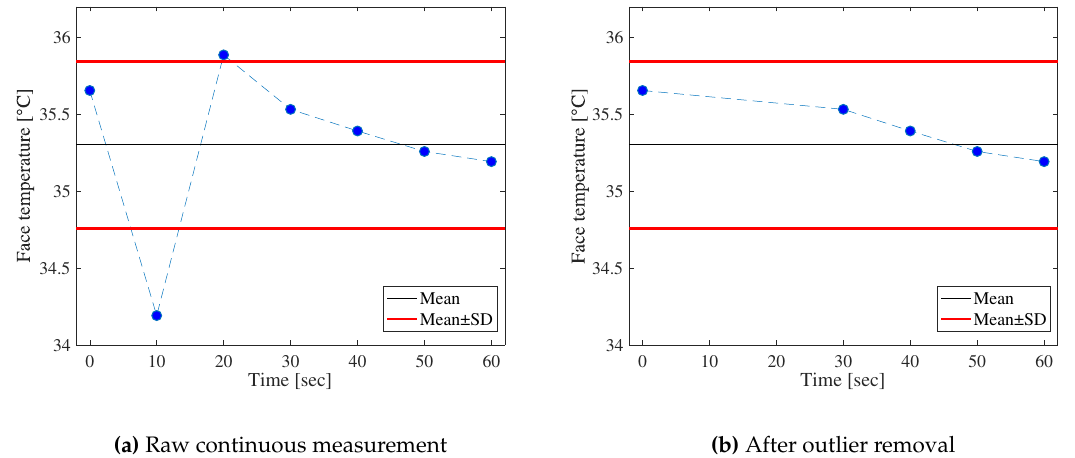
Figure 14. Example of removal defining